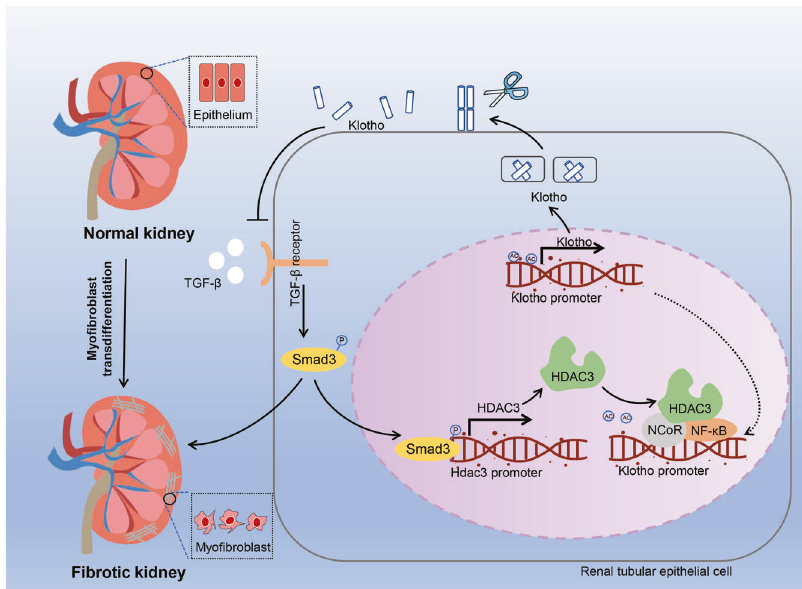
Fig. 5 Scheme of HDAC3-mediated renal fi brosis. Renal injury enhances the production of TGF- β , which promotes myo fi broblast differentiation and activates Hdac3 transcription and Smad signaling. Subsequently, HDAC3, together with NF- κ B and NCoR, bind to and deacetylate the Klotho promoter, downregulating Klotho and exacerbating renal fi brosis. HDAC3 inhibition preserves the expression of Klotho, inhibiting the TGF- β receptor and alleviating renal fi